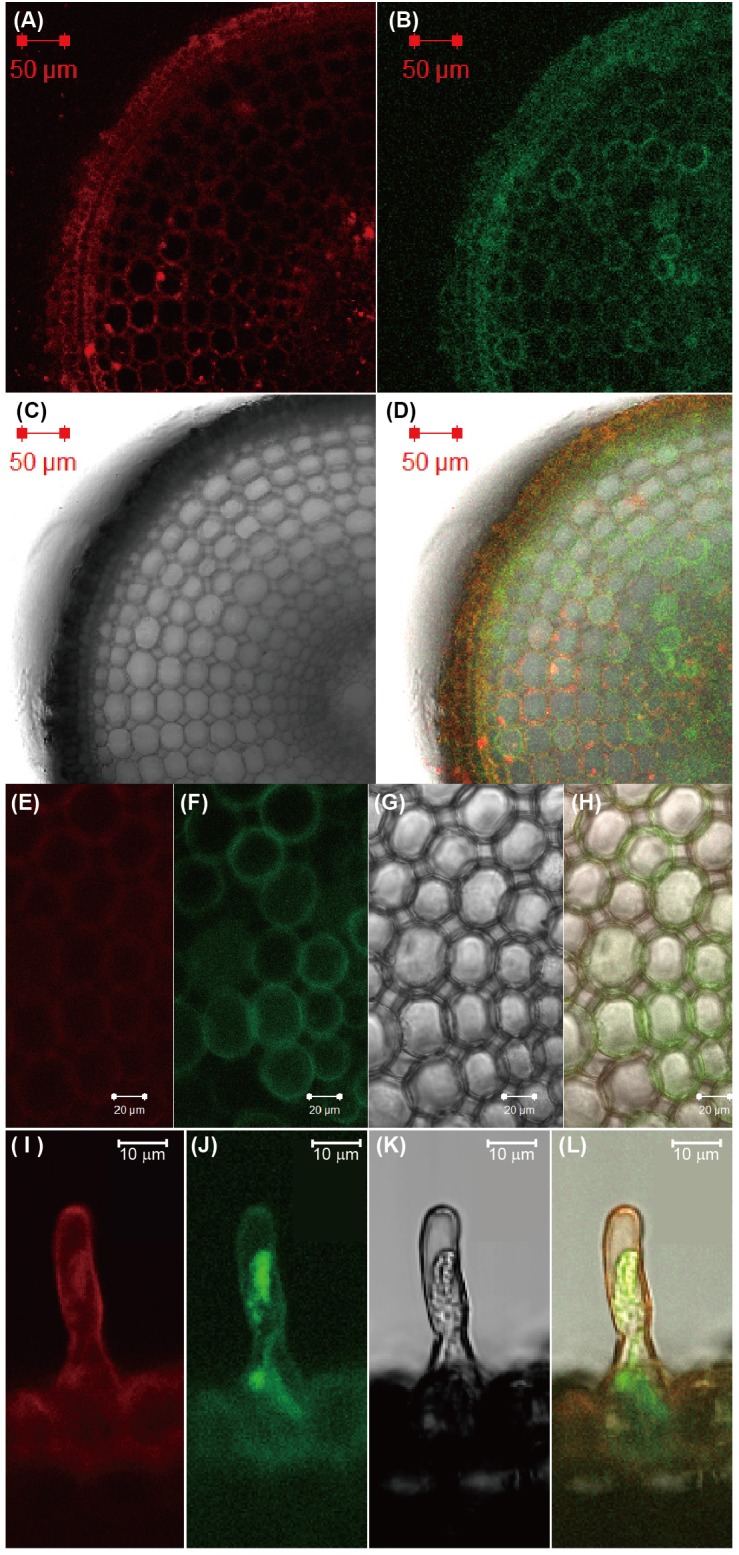
Subcellular localization of ENA1-GFP in rice roots. (A,E,I) Fluorescence image of FM65-stained rice roots. (B,F,J) Fluorescence image of GFP. (C,G,K) Differential interference contrast image. (D,H,L) Overlay.